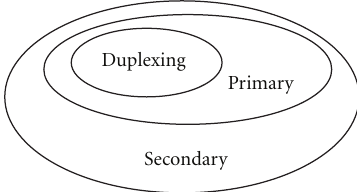
Figure 1: Duplexing interference constraint.